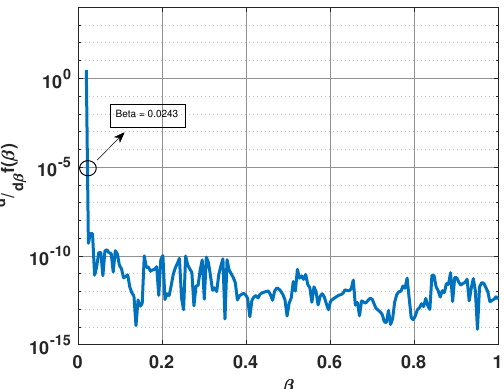
Figure 6. Derivative of f ( β ) versus β for a uniform linear array of 15 elements in the presence of three signals at 55 ◦ , 75 ◦ , and 95 ◦ .